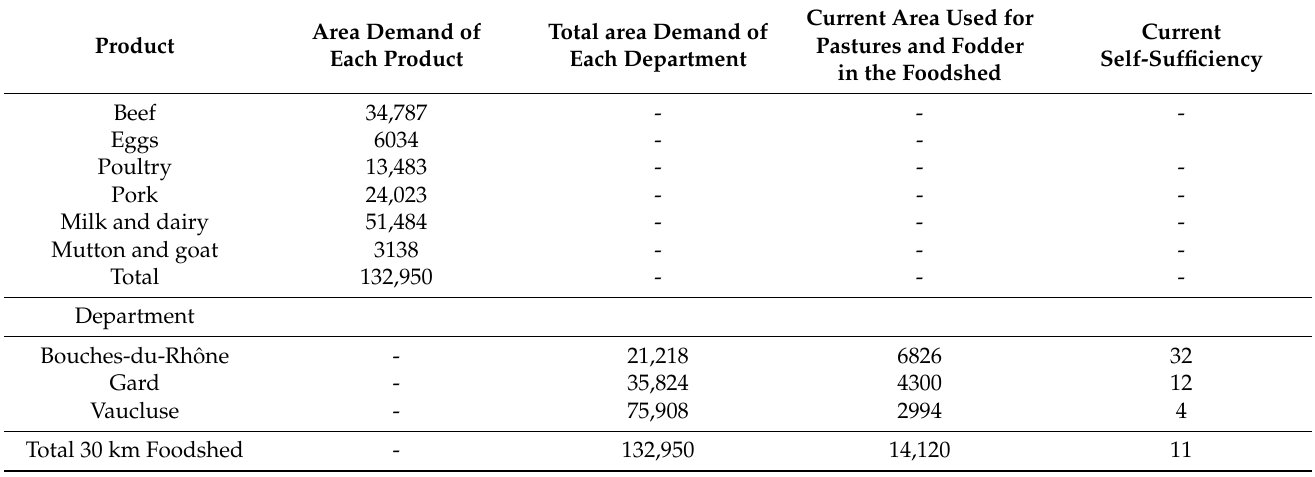
Table 2. Results of the area demand, current area used, and self-sufficiency of animal products for the three departments and the